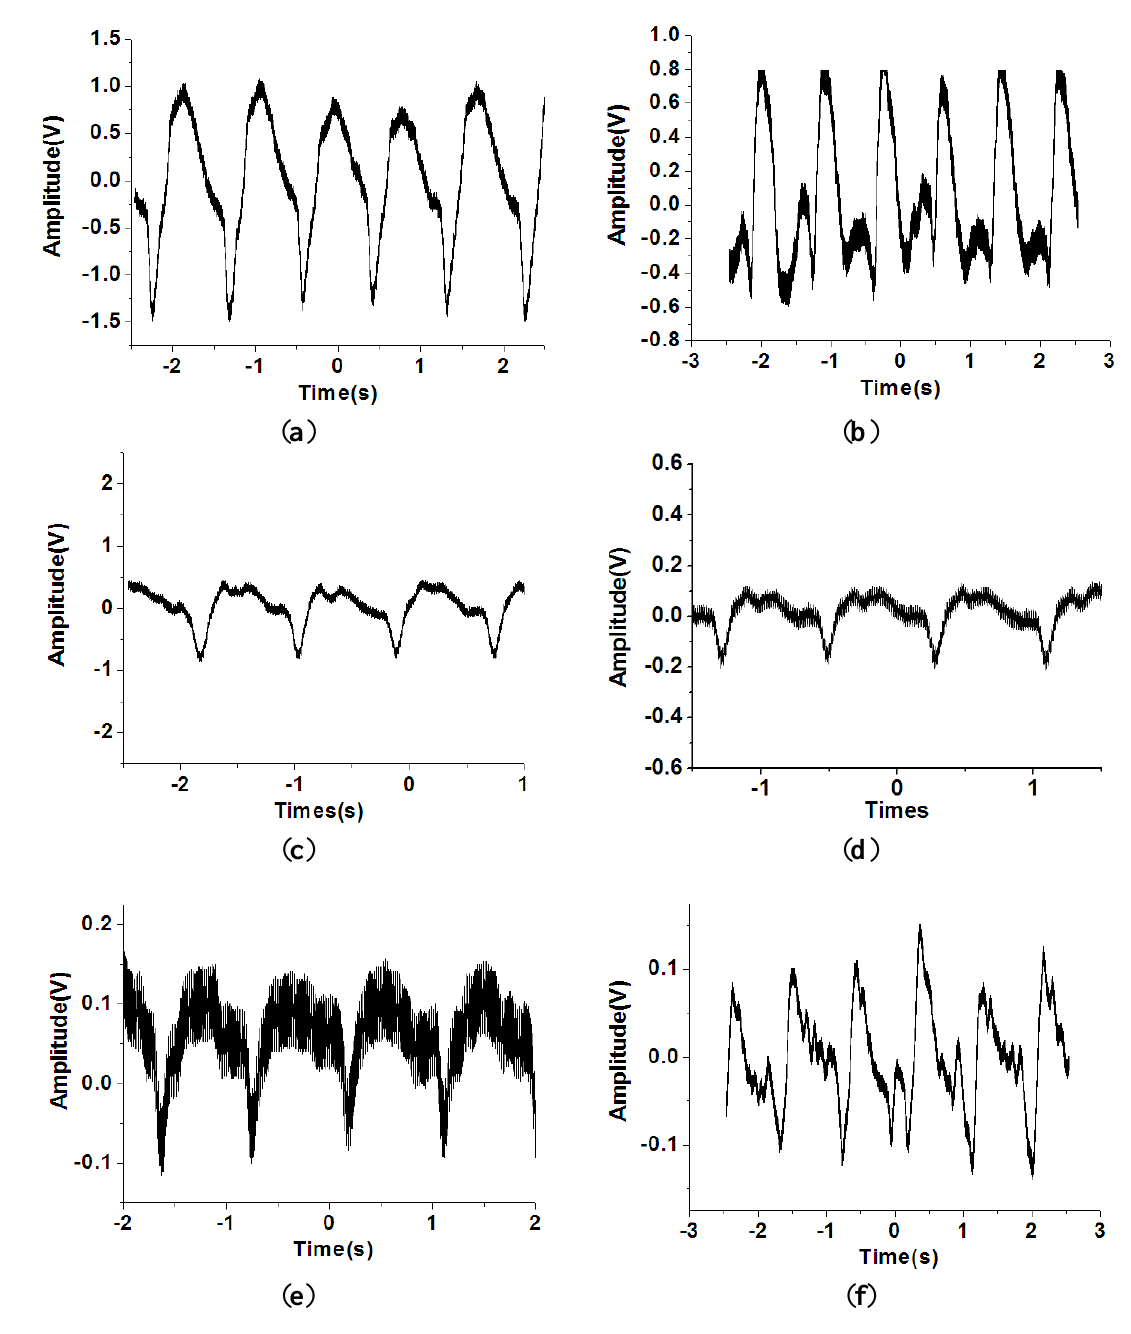
Figure 8. A PZT flexible tactile sensor to sense different human body region ( a ) carotid